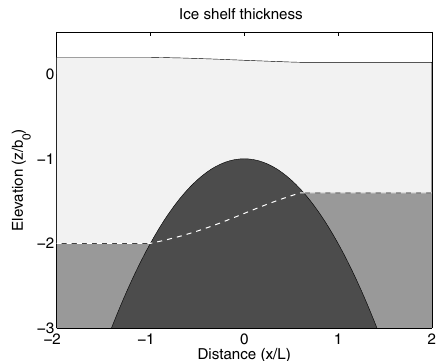
Figure 6. A sketch of the ice-thickness distribution near the Lomonosov Ridge, where the ice flows from the left (Amerasian side) to the right (Eurasian side). A parabolic ridge shape is used (Eq. 33) and the ice thickness is given by Eq. (28), which assumes that the longitudinal deviatoric stress is negligible in the grounded ice. The vertical coordinate is normalized with b r the ridge-crest depth. The white dashed line indicates the base of floating ice, which mirrors the ice-surface elevation. Near the two grounding lines, there will be narrow transitions zones where the longitudinal deviatoric stress is not negligible and local ice rumples can form (Schoof, 2007b; Goldberg et al., 2009; Favier et al., 2012). How- ever, the depicted simple solution should give the approximate dif- ference in grounding-line depths across the ridge. Note that a tran- sition layer downstream of the ridge where the ice shelf thins is not shown here; see Fig.